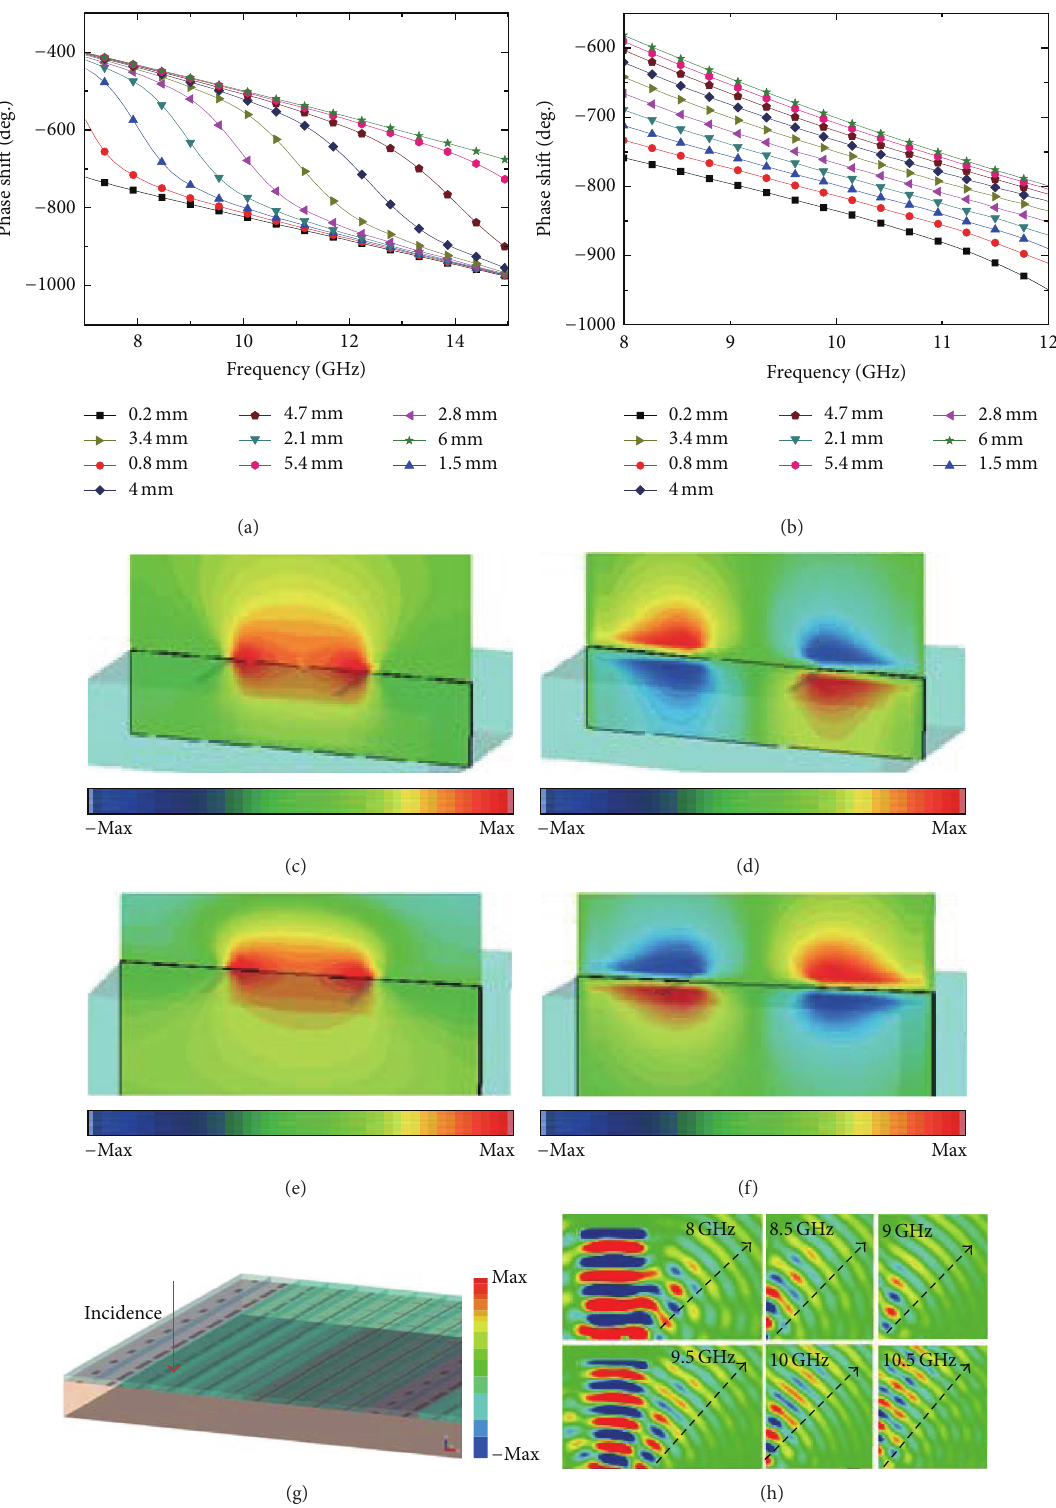
Figure 33: Reflection phases for different values of gap width 𝑔 for thickness of (a) 𝑑 = 2mm and (b) 𝑑 = 6 mm. The other geometrical parameters are chosen as 𝑙 = 4mm and 𝑤 = 0.2 mm. (c) 𝑦 -component and (d) 𝑧 -component of electric fields for 𝑑 = 2 mm, 𝑔 = 2.8 mm, and 𝑓 = 10 GHz. (e) 𝑦 -component and (f) 𝑧 -component of electric fields for 𝑑 = 6mm, 𝑔 = 2.8 mm, and 𝑓 = 10 GHz. (g) Schematic of the gradient metasurface. (h) Electric field 𝐸𝑦 distribution in the scattering region at normal incidence for 8, 8.5, 9, 9.5, 10, and 10.5 GHz. The dashed black arrows indicate the propagation direction evaluated by sin −1 (𝑘𝑥/𝑘) . Figures are reproduced from